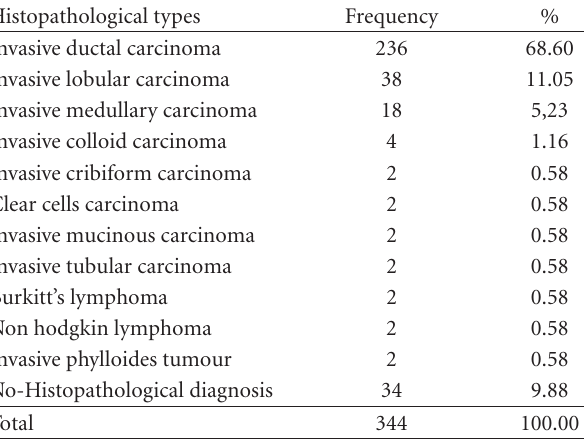
Table 4: Histopathological types of the breast cancer of the population study.